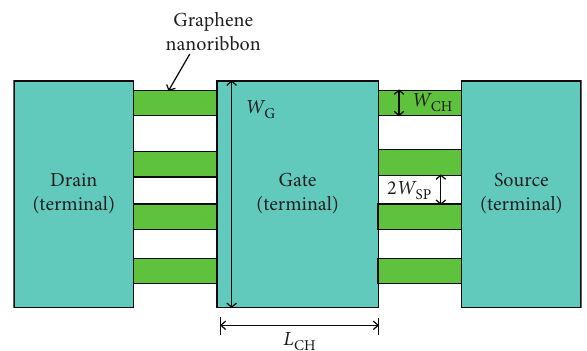
Figure 1: The structure of a MOSFET-like GNRFET.